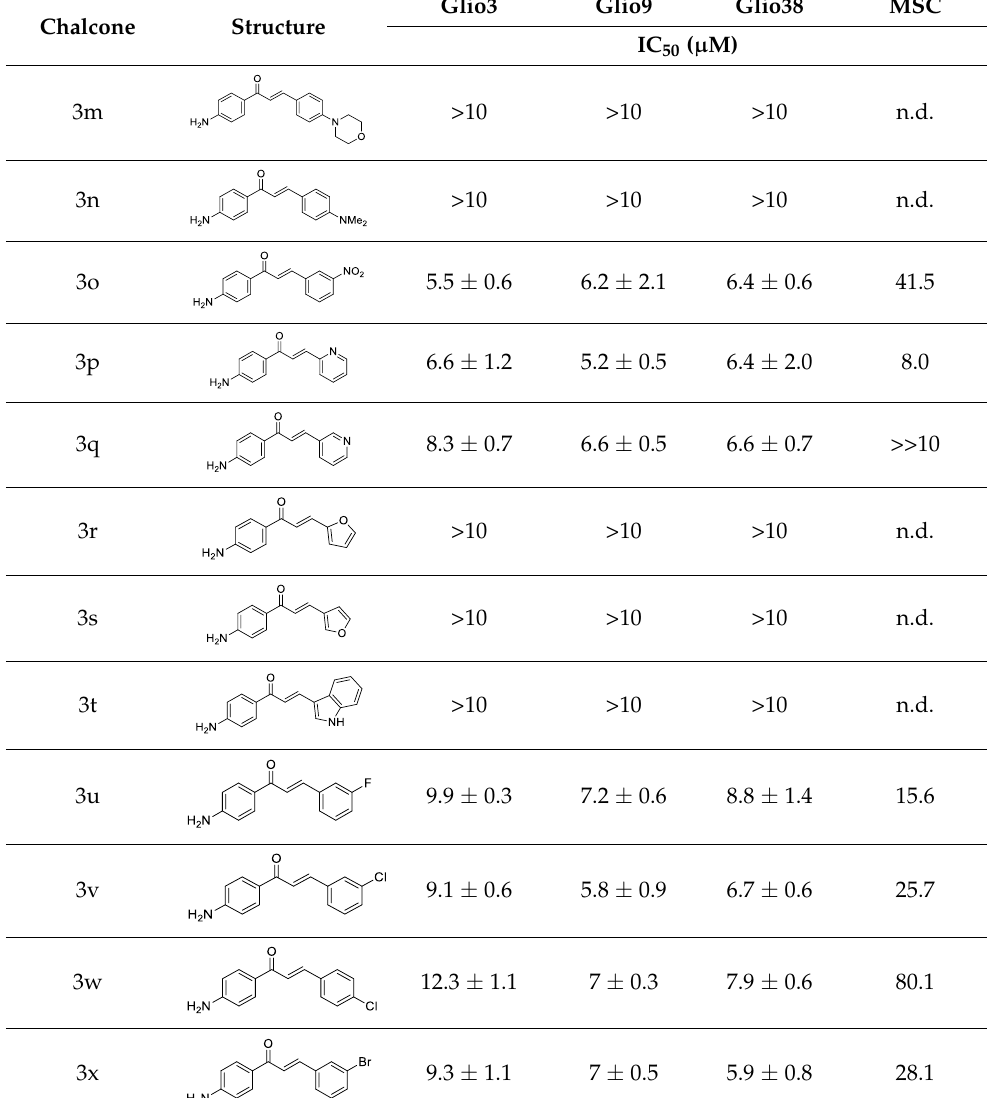
Molecular structure and IC 50 ( µM) of 4′ -aminoacetophenone chalcone derivatives in GSC lines Glio3, Glio9, Glio38 and mesenchymal stem cells (MSC). Data presented as IC 50